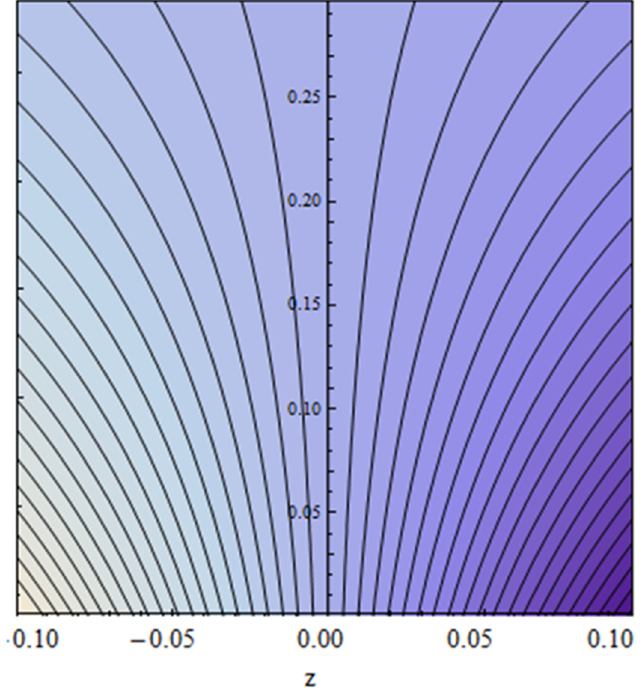
Figure 20. Streamlines impact at Br = 0.3 for constant viscosity.